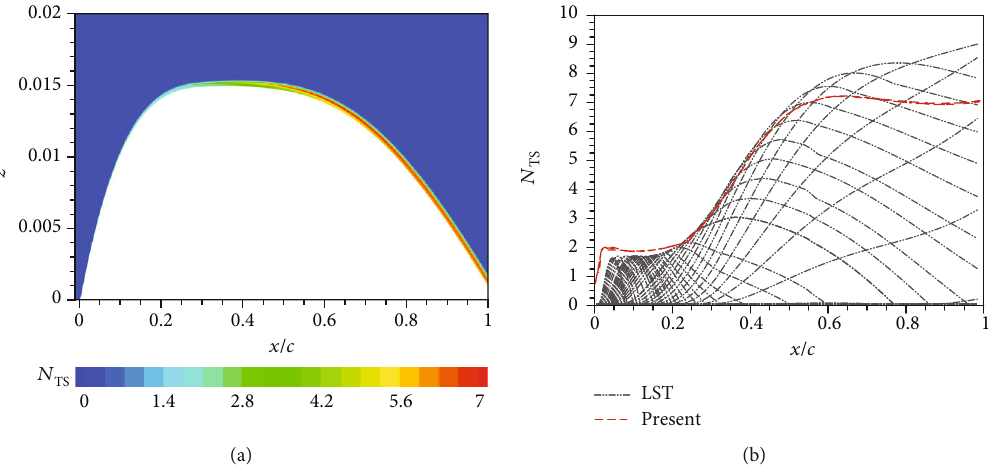
Figure 16: The predicted (a) N contour and (b) comparison with standard LST analysis results at Re = 5 : 4 × 10 7 /m . TS